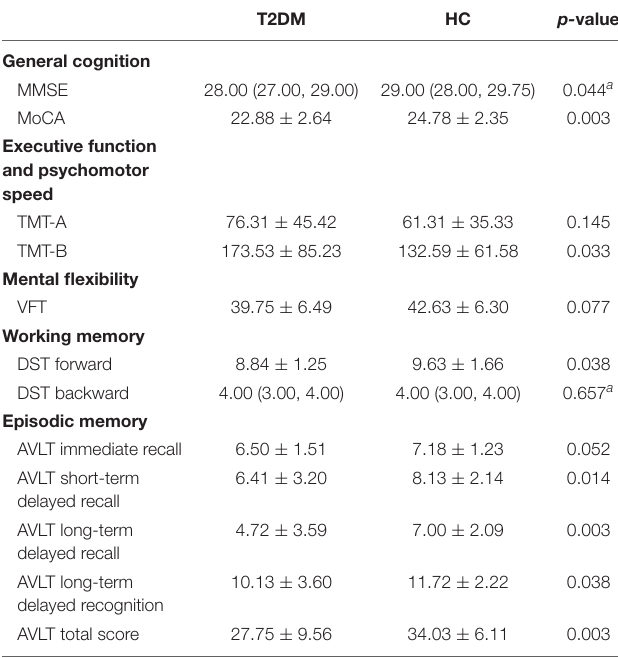
TABLE 2 | Comparisons of neuropsychological test performance between the T2DM group and HC group. T2DM HC p-